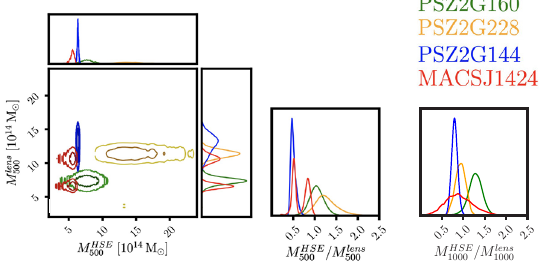
Figure 4. tSZ / κ map for MACS J0717.5 + 3745. Map pixels for which κ < 0.5 are set to zero. Con- 1 / 2 tours correspond to [0.5, 1, 1.5, 2, 2.5] levels in κ -map. The map has been smoothed with a 18” Gaussian